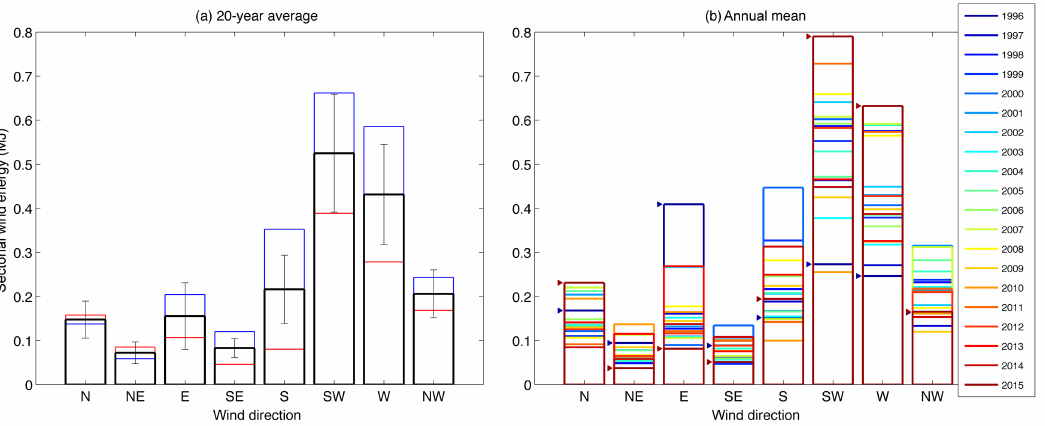
Figure 4. Annual mean wind energy at Vlieland weather station, divided into eight sectorial directions. In (a) the average over the 20-year record (1996–2015), in black. The vertical line segments represent the standard deviations for each sector, as an indication of the typical interannual variability. Also shown are the averages of the summer half-year (in red) and winter half-year (in blue). In (b) the sectorial annual mean wind energy for all individual years. For clarity, the extreme years 1996 (dark blue) and 2015 (dark red) are highlighted with triangles alongside the